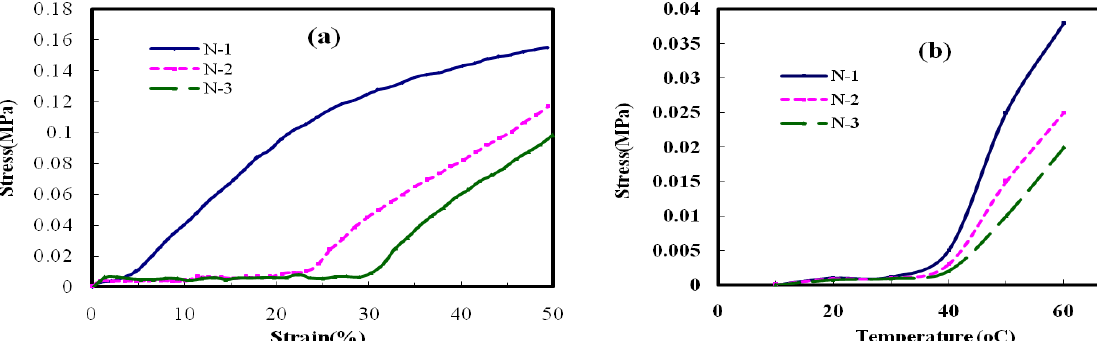
Figure 7. ( a ) Stress vs . strain up to an extension of 50% at 60 ° C and ( b ) corresponding recovery stress for PEG-H1